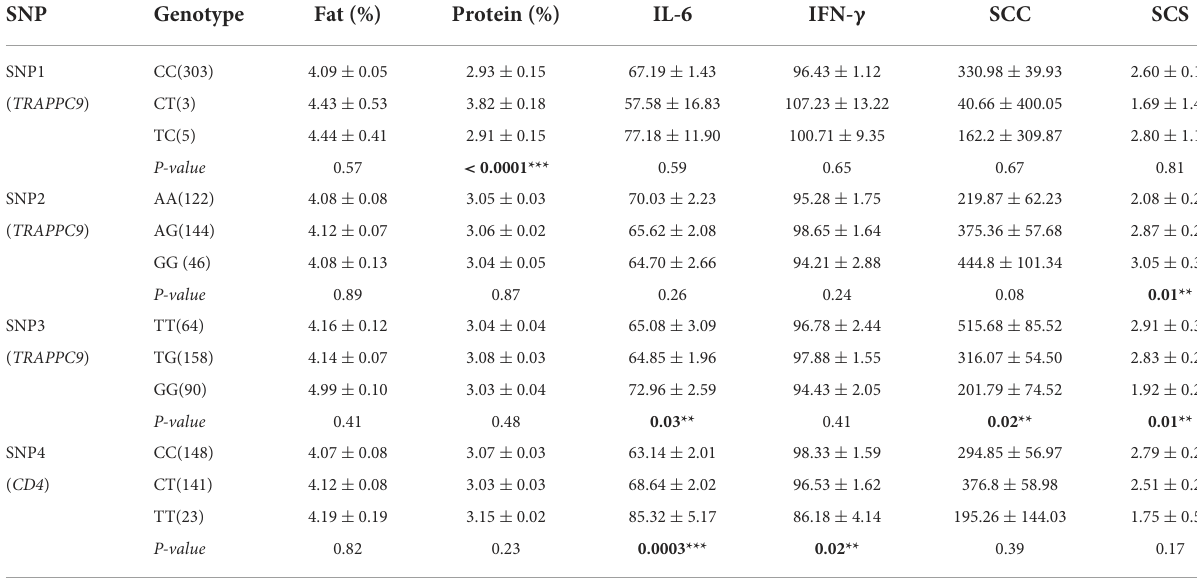
TABLE 3 Association of SNPs in TRAPPC9 and CD4 genes on SCC, SCS, milk production, and serum cytokines traits in Chinese